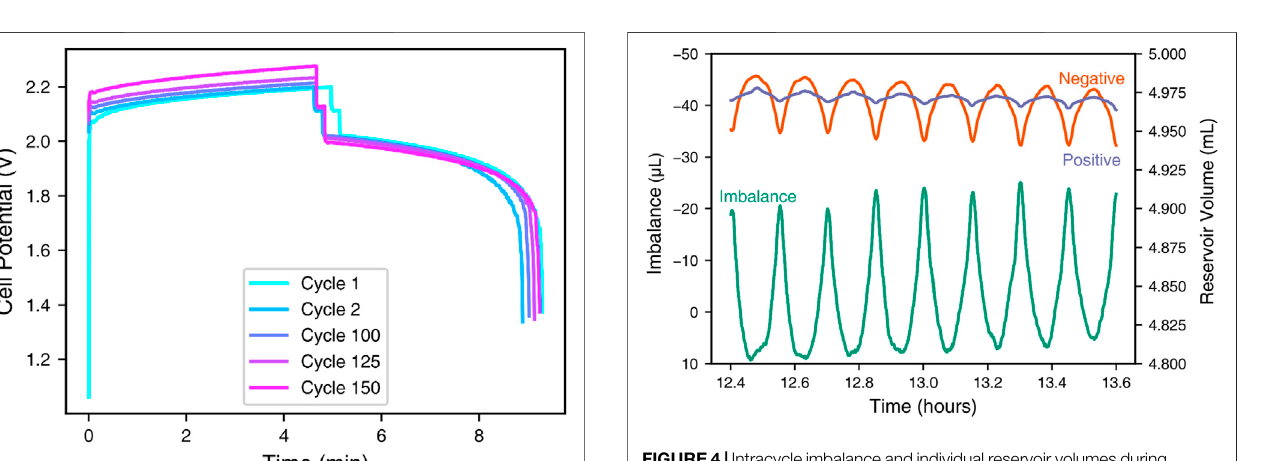
FIGURE4| Intracycleimbalance andindividualreservoirvolumesduring the stable, balanced cycling period achieved after 12 h of running with the control